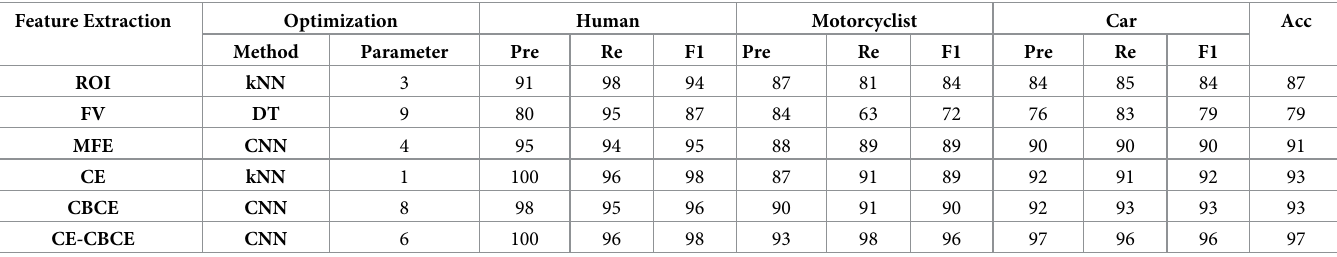
Table 5. Best result with its method of optimization and parameter for each class of objects. Feature Extraction Optimization Human Motorcyclist Car Acc Method